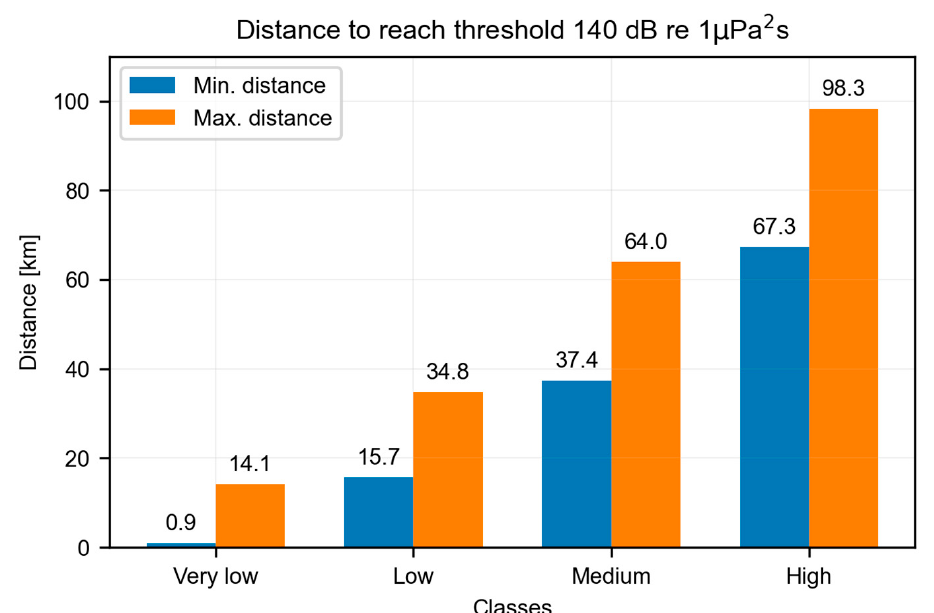
Figure 3. Propagation radius range of exceedance of an SEL of 140 dB re 1 µPa 2 s for different value code classes (pile driving). The transmission loss was calculated with Formula (1).